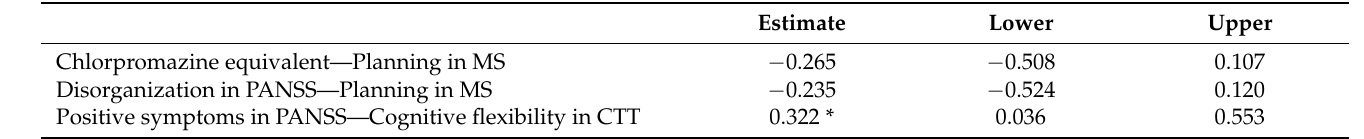
Table 6. Standardized regression weights for relations between clinical factors, psychopathological symptoms, and different aspects of executive functions in NDS patients.